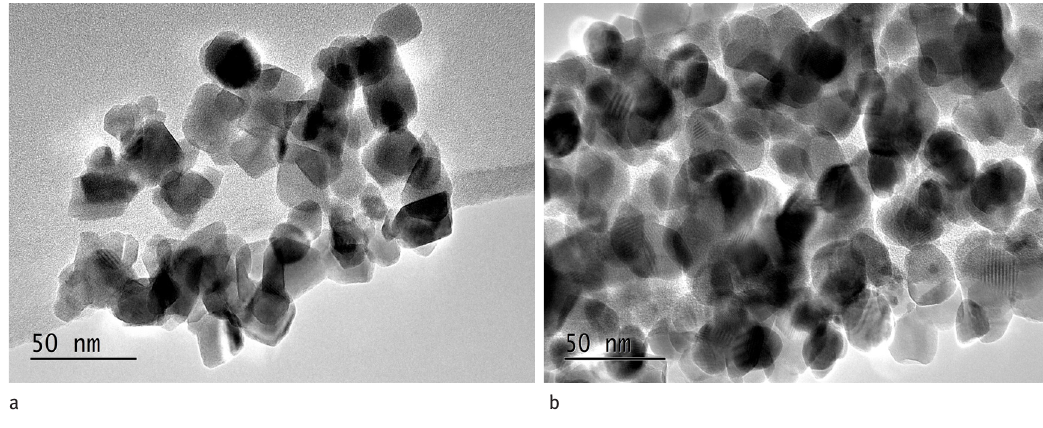
Figure 1: TEM micrographs of ZNF-Eu1 (a) and ZNF-Tb5 (b).